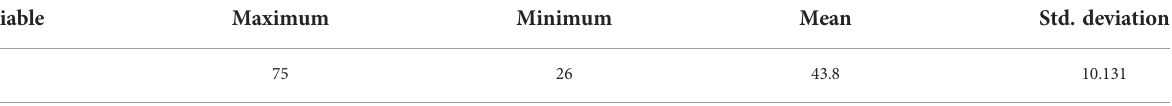
TABLE 3 Summary of continuous variables for breast cancer